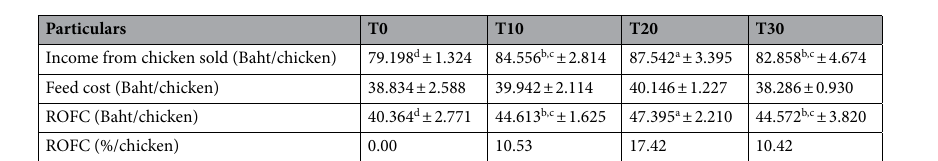
Table 2. The ROFC (Baht/chicken) of Male chicken under different treatment groups. ROFC Return over feed cost, means within a row with different superscript differ significantly (p-value < 0.05).